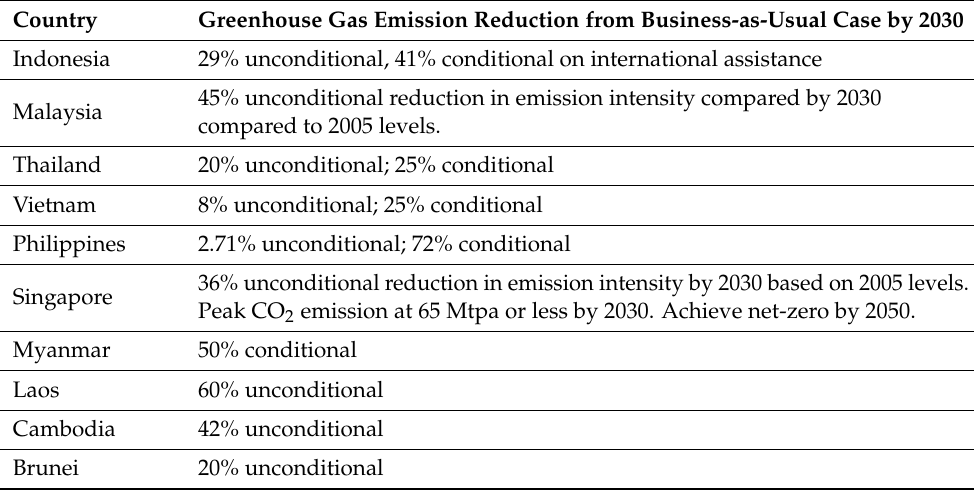
Table 2. National determined contribution to Paris Agreement by ASEAN countries [13].